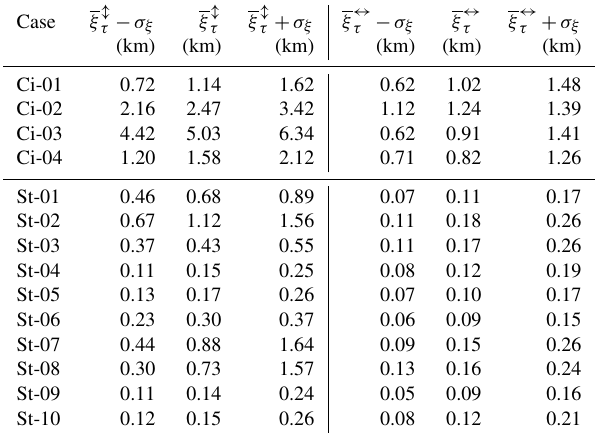
Table 2. Decorrelation length calculated for the retrieved fields of τ from the CARRIBA (Ci-01–Ci-04) and VERDI (St-01–St-10) cam- paigns. Vertical arrows ( (cid:108) ) indicate the calculation of P 2 τ (L x ,L y ) and subsequent derivation of ξ τ along L y , horizontal arrows ( ↔ ) along L x . Furthermore, ξ τ is the average of all pixels, ξ τ − σ ξ is the average minus standard deviation, and ξ τ + σ ξ is the average plus standard deviation.